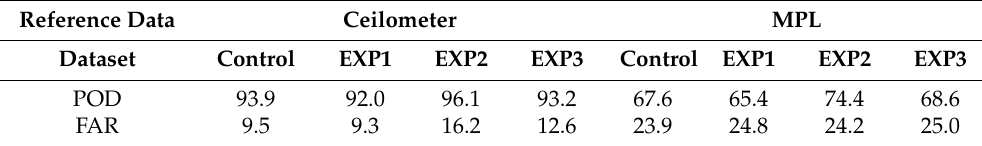
Table 7. The probability of detection (POD) and false alarm ratio (FAR) scores of the four experimental datasets with the reference data from both ceilometer and MPL. Here, POD is estimated by hits/(hits + misses), while FAR is estimated by false alarms/(false alarms + hits).